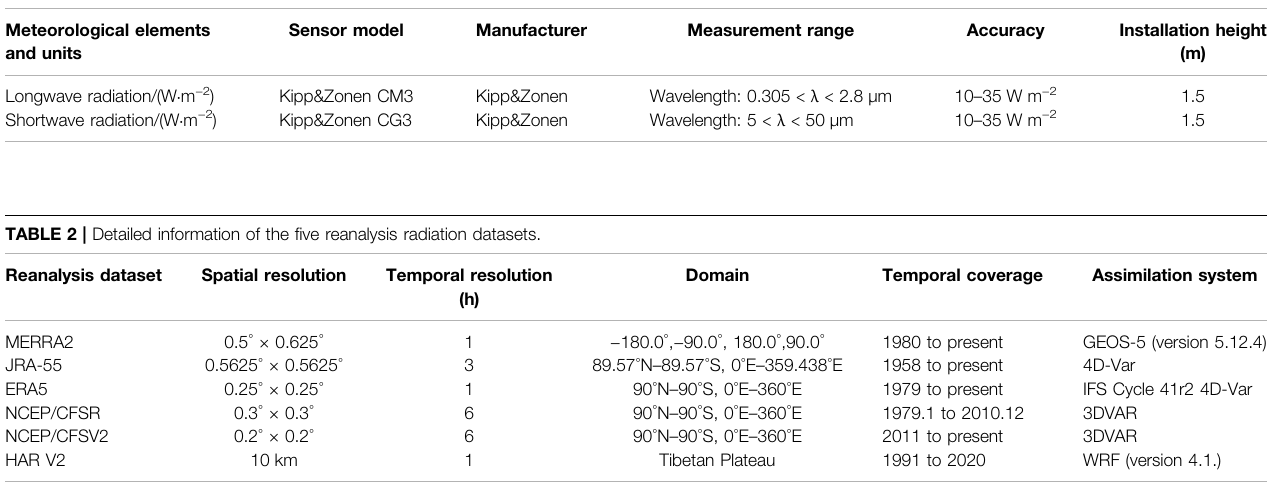
TABLE 1 | Technical parameters and installation height of radiation sensors.